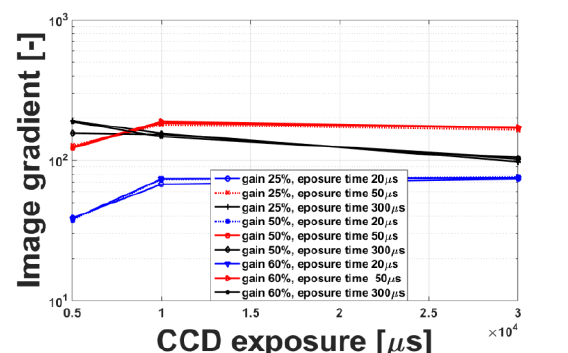
Fig. 17. Image gradient depending on CCD exposure time for different setup. Hamamatsu